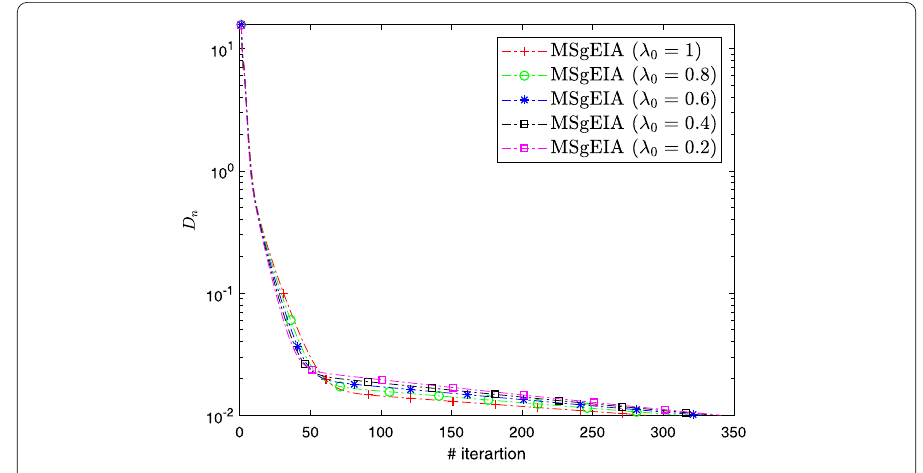
Figure 5 Experiment 5.2: Algorithm 2 behavior in terms of iterations relative to different values of λ 0